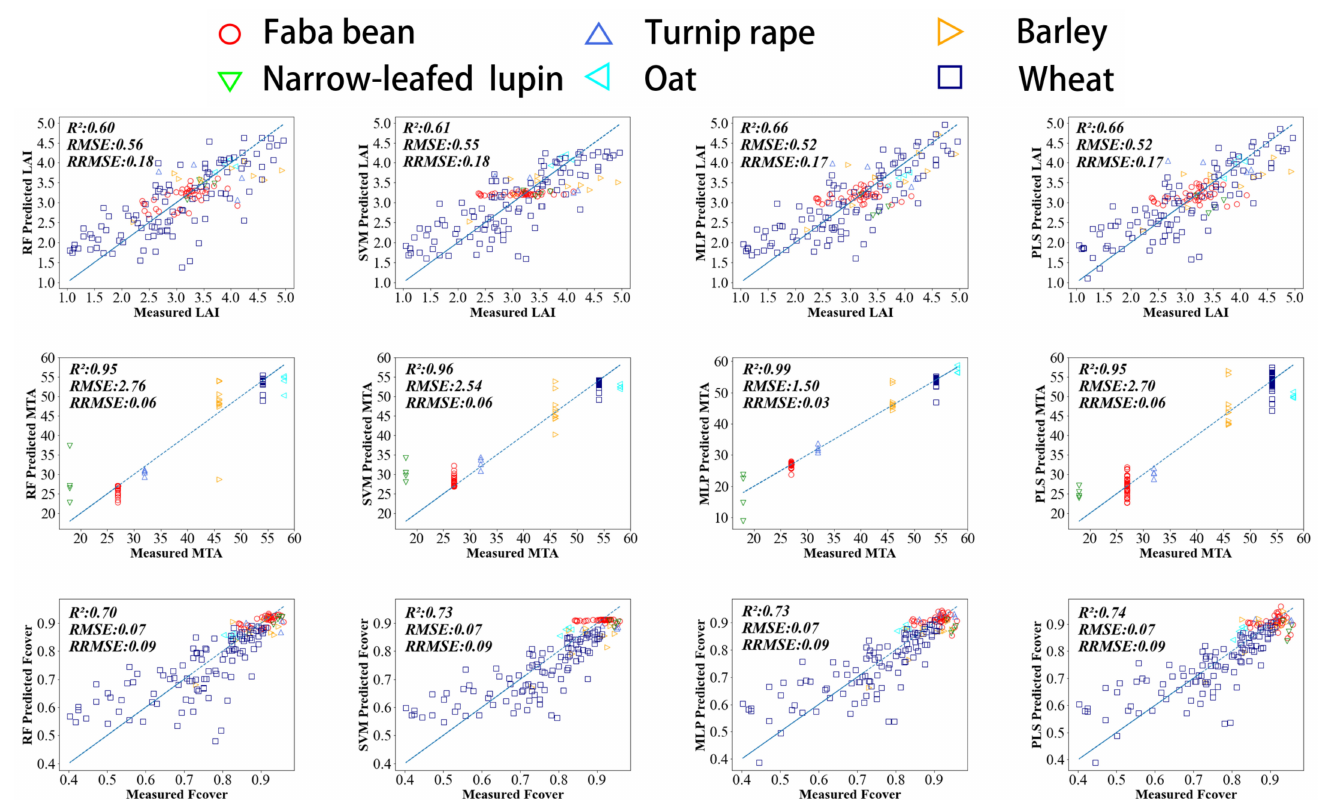
Figure 7. Performance of machine learning algorithms combined with optimized input